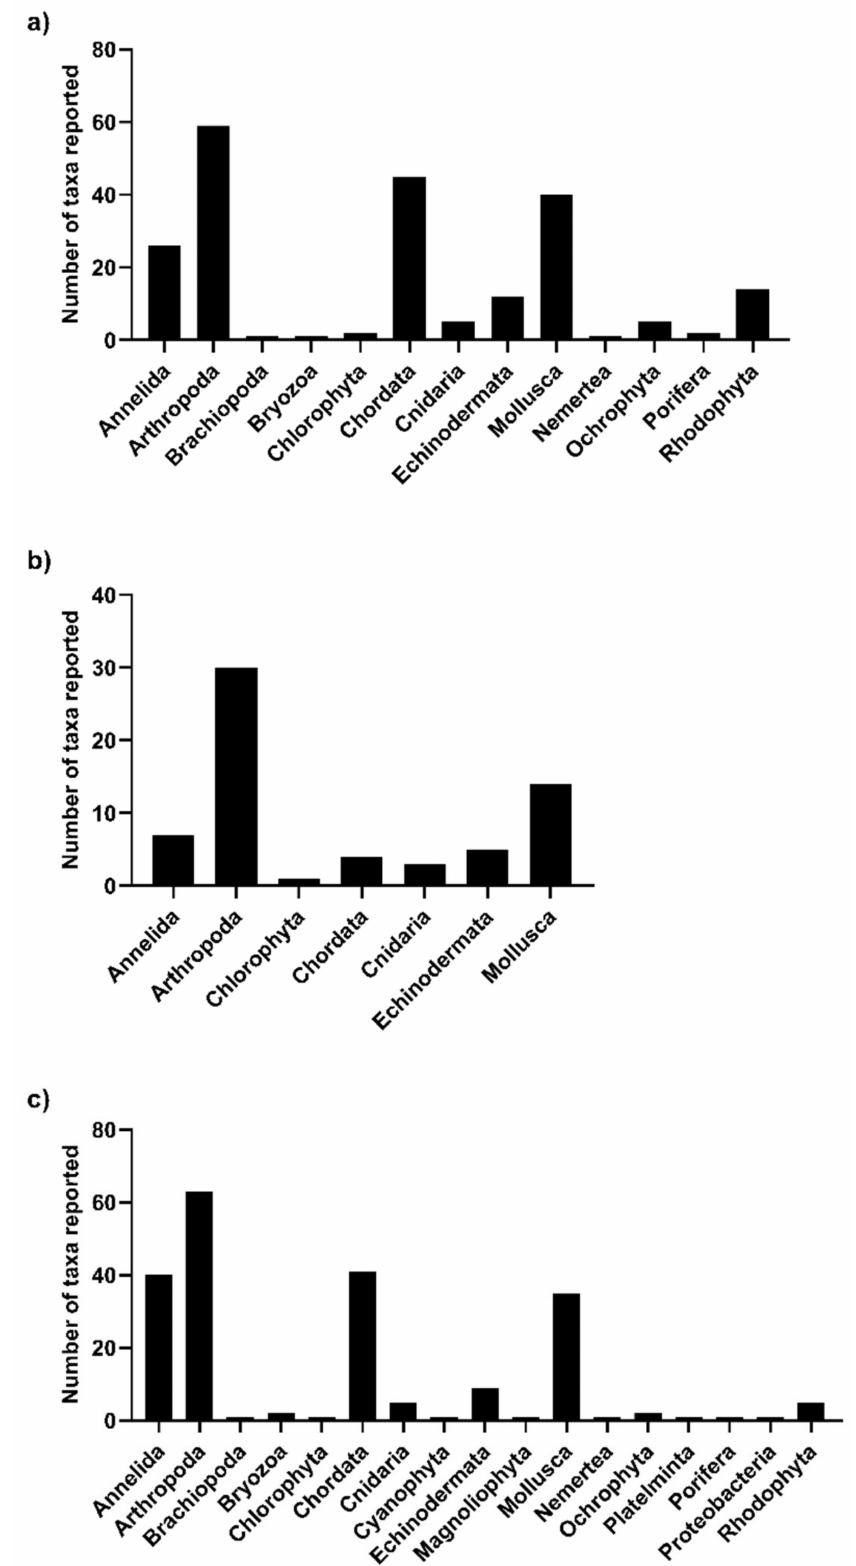
Figure 4. Number of kelp-forest associated taxa reported per Phyllum. ( a ) L. trabeculata ; ( b ) L. berteroana/spicata ; ( c ) M. pyrifera